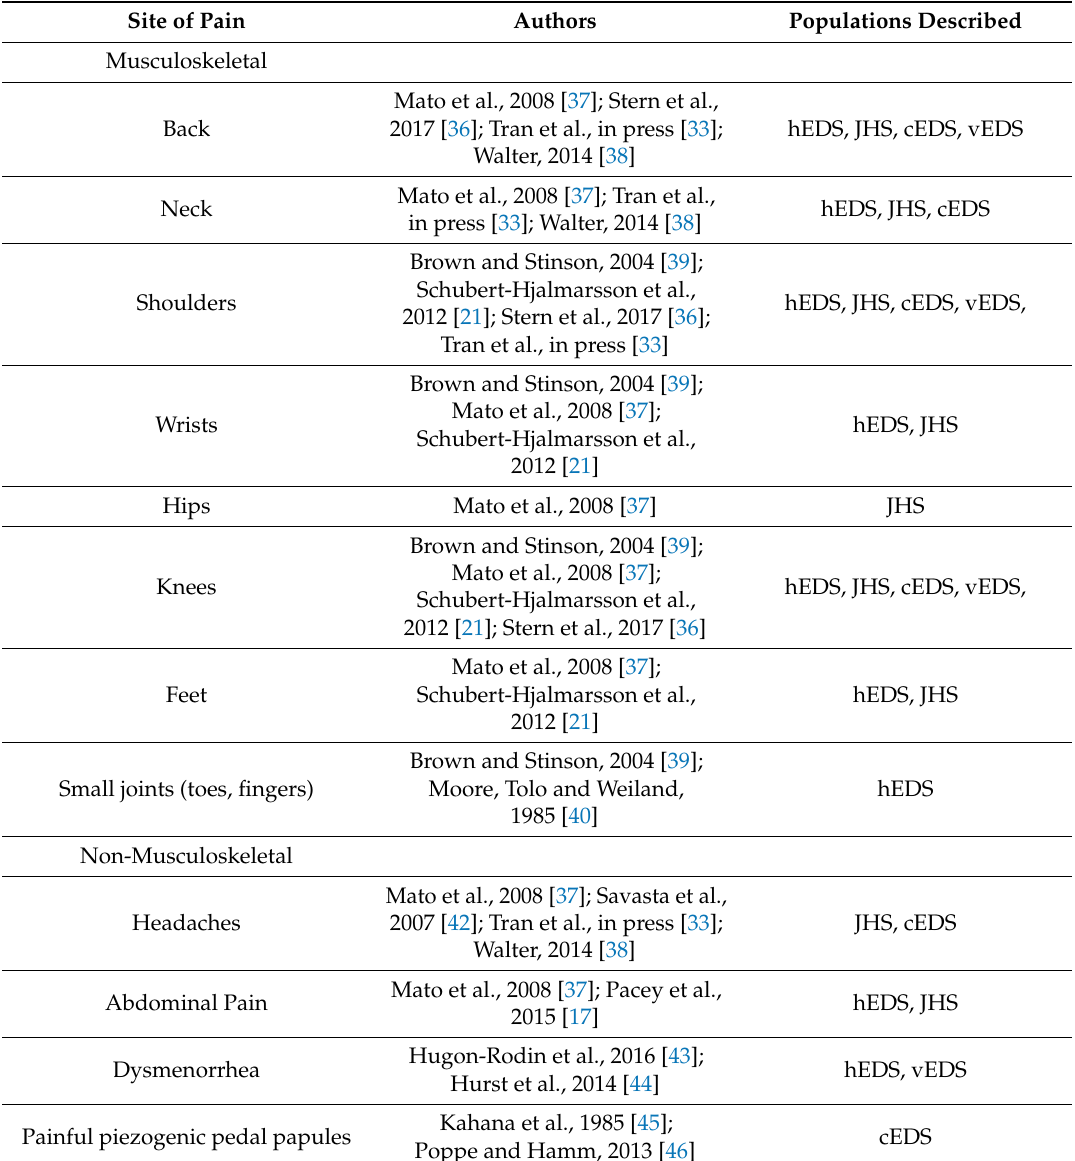
Table 1. Summary of Pain Sites in Pediatric Hypermobility